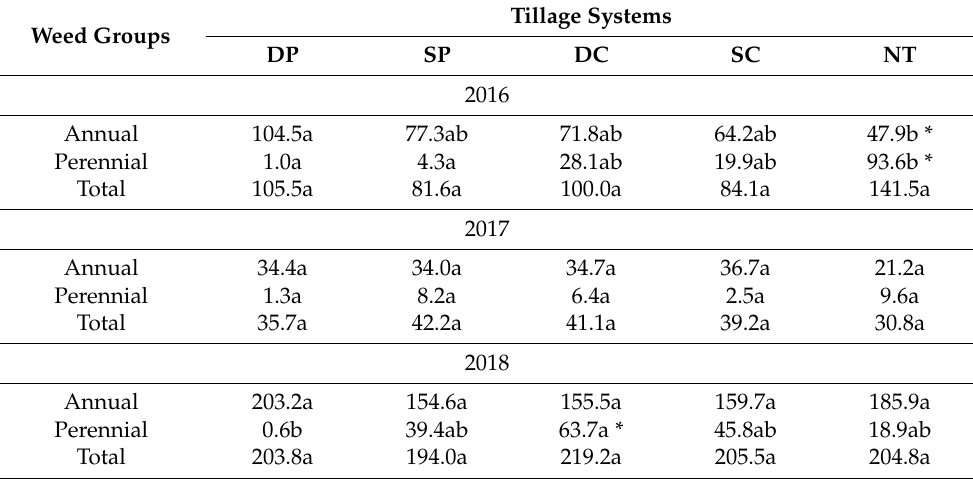
Table 2. Air-dried biomass (g m − 2 ) of the aerial part of weeds at faba bean BBCH 75–79 growth stages as influenced by the tillage system in